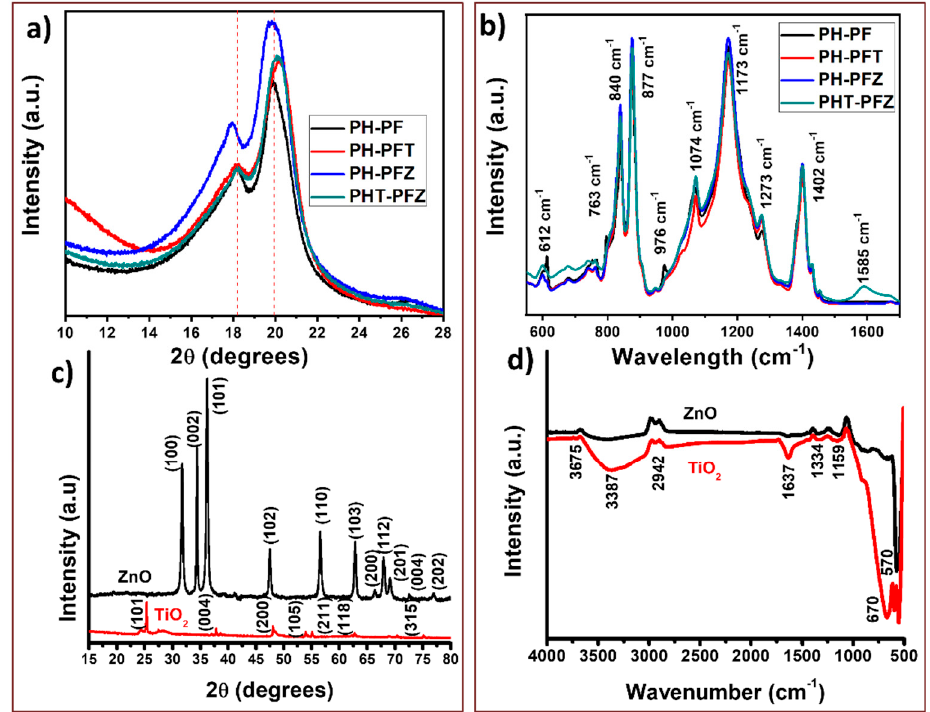
Figure 4. XRD patterns and FTIR spectra of ( a ) the PVDF-HFP/PVDF composites and ( b ) the nanomaterials, ( c , d ) respectively show the XRD and FTIR spectra of ZnO and TiO2.